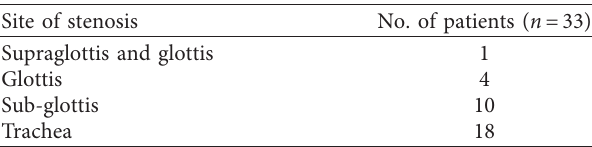
Figure 3: Supraglottic and glottic stenosis. Table 2: Sites of airway stenosis.